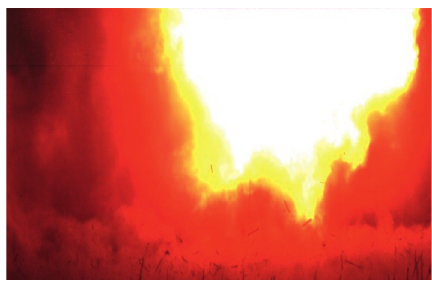
Figure 6: Photograph of explosion.